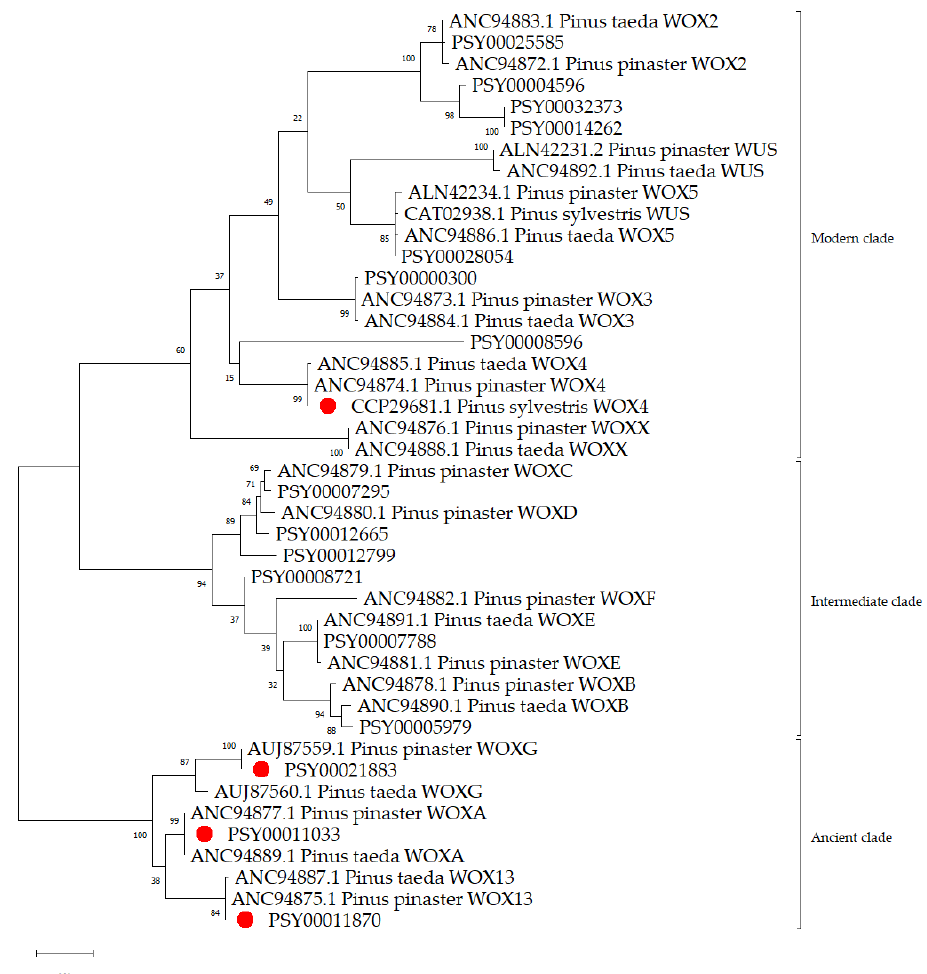
Figure 2. Phylogenetic relationships built based on a comparative evolutionary analysis of the amino acid sequences of potential Scotch pine WUS/WOX proteins (PSY) and known proteins of the WUS/WOX family of other Pinus species. Phylogenetic analysis by maximum likelihood (ML) method, based on Jones–Taylor–Thornton (JTT) model with a discrete gamma distribution (1 G, 5 categories) as the best model for gene phylogeny reconstruction. Branch length is estimated at genetic distance (number of substitutions per site). Significant bootstrap values (percentage of trees in which associated taxa are clustered together) for 1000 replicates are shown at the branch base. An access code in the NCBI database is next to the protein names. The red dots are the proteins encoded by the PsWOXs , which were analyzed.